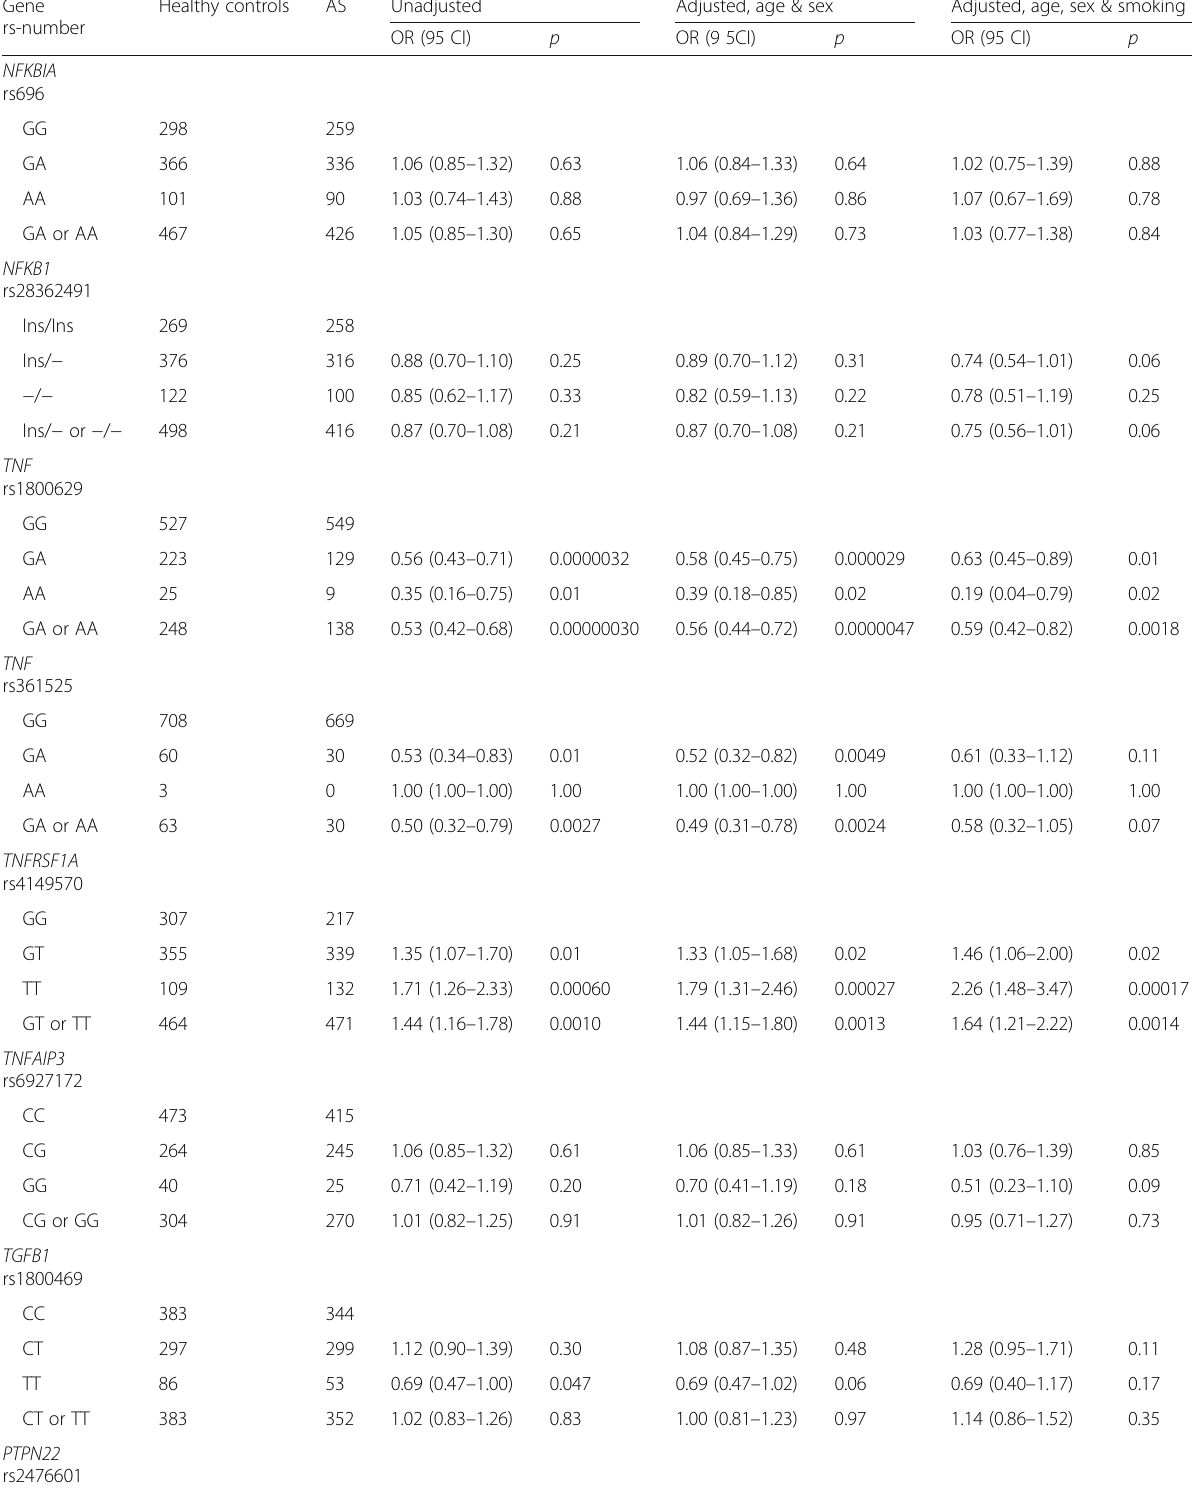
Table 1 Odds ratios (OR) and 95% confidence interval (95CI) for genotypes studied among healthy controls and patients with ankylosing spondylitis (AS)